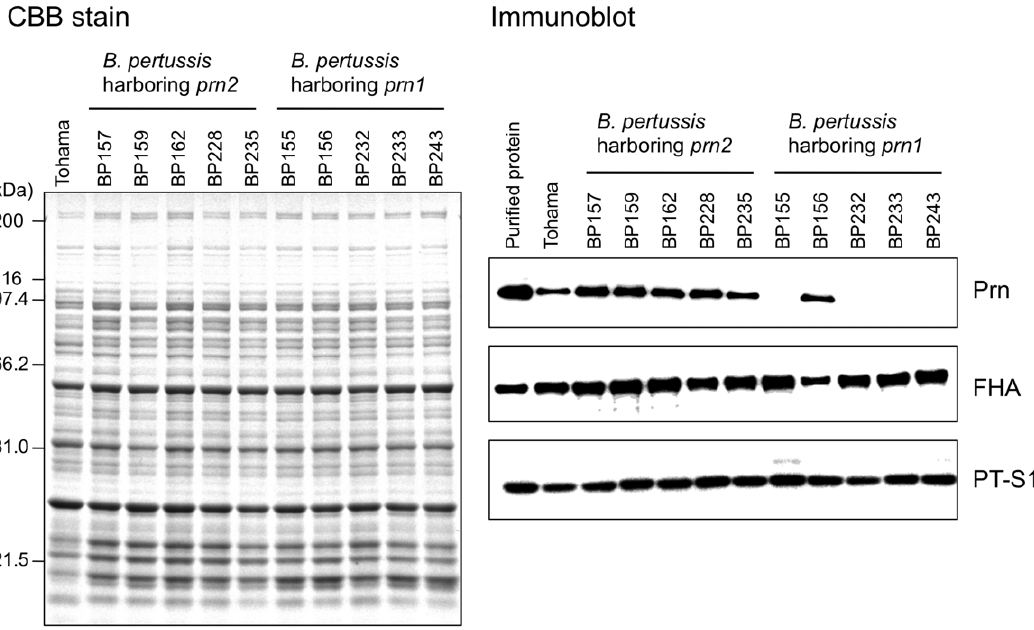
Figure 1. Prn expression in B.pertussis clinical isolates. The isolates harboring prn2 allele (BP157, BP159, BP162, BP228, and BP235) and prn1 allele (BP155, BP156, BP232, BP233, and BP243) were cultured on CSM plates. Total protein (10 m g) extracted from the bacterial cells was separated by SDS-PAGE followed by CBB R-250 staining (left panel). Immunoblots (1 m g protein/lane) were incubated with anti-Prn1, anti-PT or anti-FHA antiserum (right panel). Ten ng of purified Prn1, PT, or FHA and total protein (1 m g) from B. pertussis Tohama were run on the gel as positive controls.